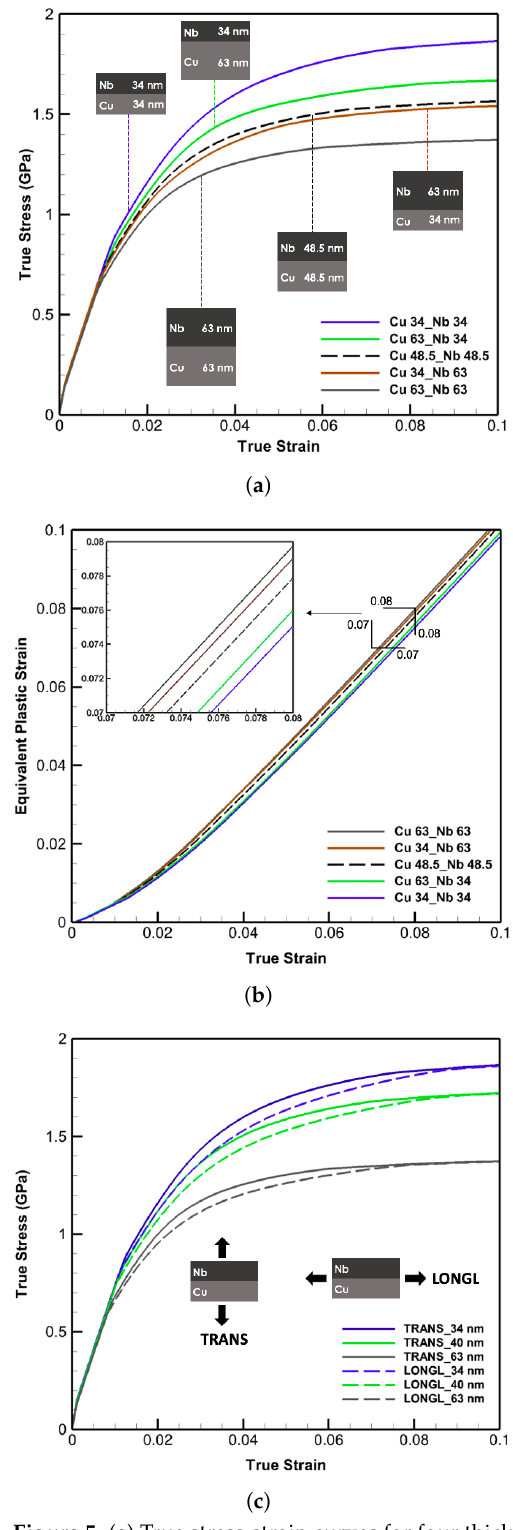
Figure 5. ( a ) True stress-strain curves for four thickness combinations of 34 nm and 63 nm as well as 48.5 nm Cu/Nb multi-layers illustrating the effect of layer combinations on the plastic deformation and flow strength. ( b ) Equivalent plastic strain versus true strain curves for the cases in ( a ) clarifying the size and layer geometrical order effects. ( c ) True stress-strain curves of 34 nm, 40 nm, and 63 nm Cu/Nb multi-layers demonstrating the effects of transverse (TRANS) and longitudinal (LONGL) loading directions plotted with solid and dash lines,